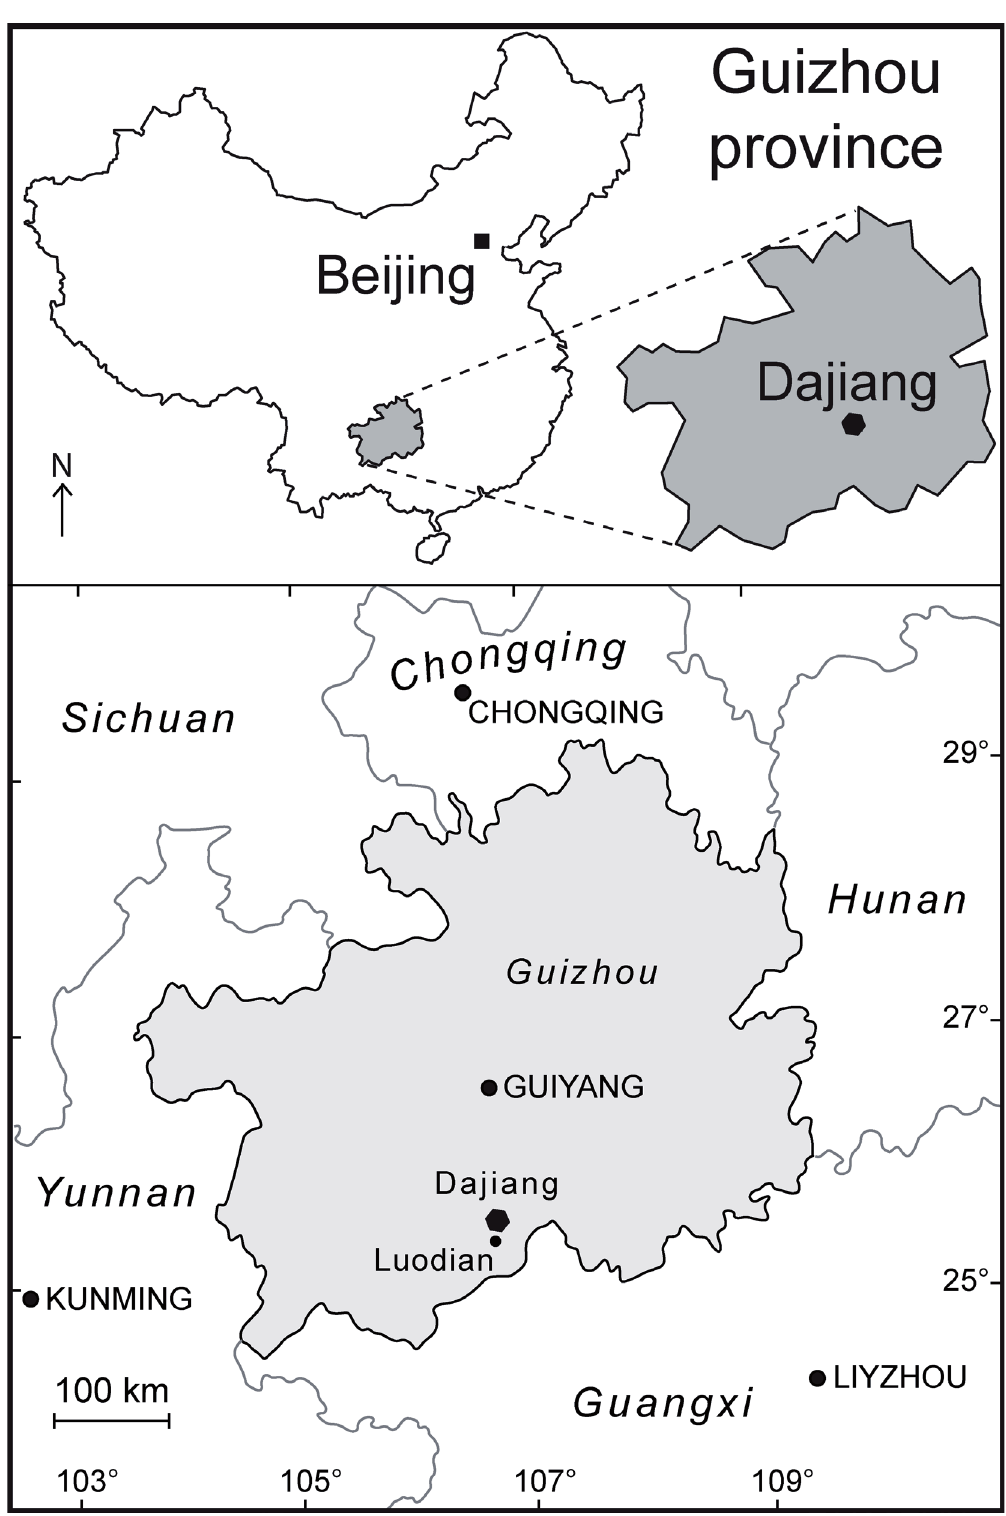
Fig. 1. Location of the Dajiang section in the southern Guizhou Province, South